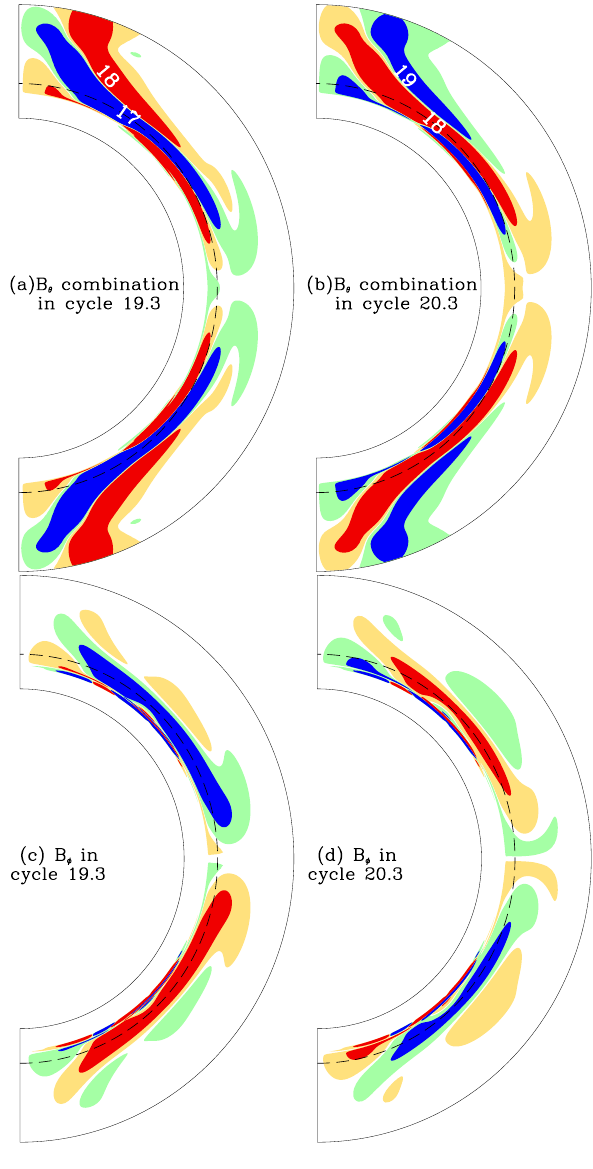
Fig. 6. (a) , (b) latitudinal component of simulated poloidal field (red and blue opposite signs) at phase 0.3 of cycles 19 and 20; (c) , (d) same for simulated toroidal